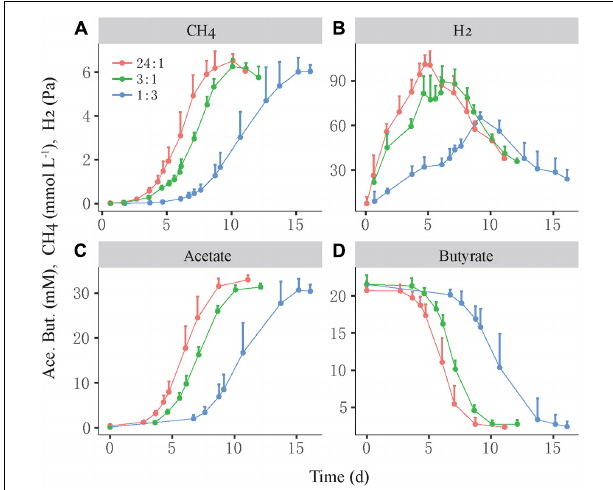
FIGURE 1 | Syntrophic oxidation of butyrate by a thermophilic coculture consisting of Syntrophothermus lipocalidus and Methanocella conradii . The production of CH 4 (A) , H 2 (B) , and acetate (C) and the consumption of butyrate (D) are shown. The actively growing S. lipocalidus and M. conradii in pure cultures were inoculated to fresh medium with different population sizes so that three levels of syntroph-to-methanogen cell ratios (i.e., 24:1, 3:1, and 1:3) were created at the beginning, which were designated as the high, middle, and low cell ratio treatments, respectively. The error bars indicate the positive values of standard deviation of four